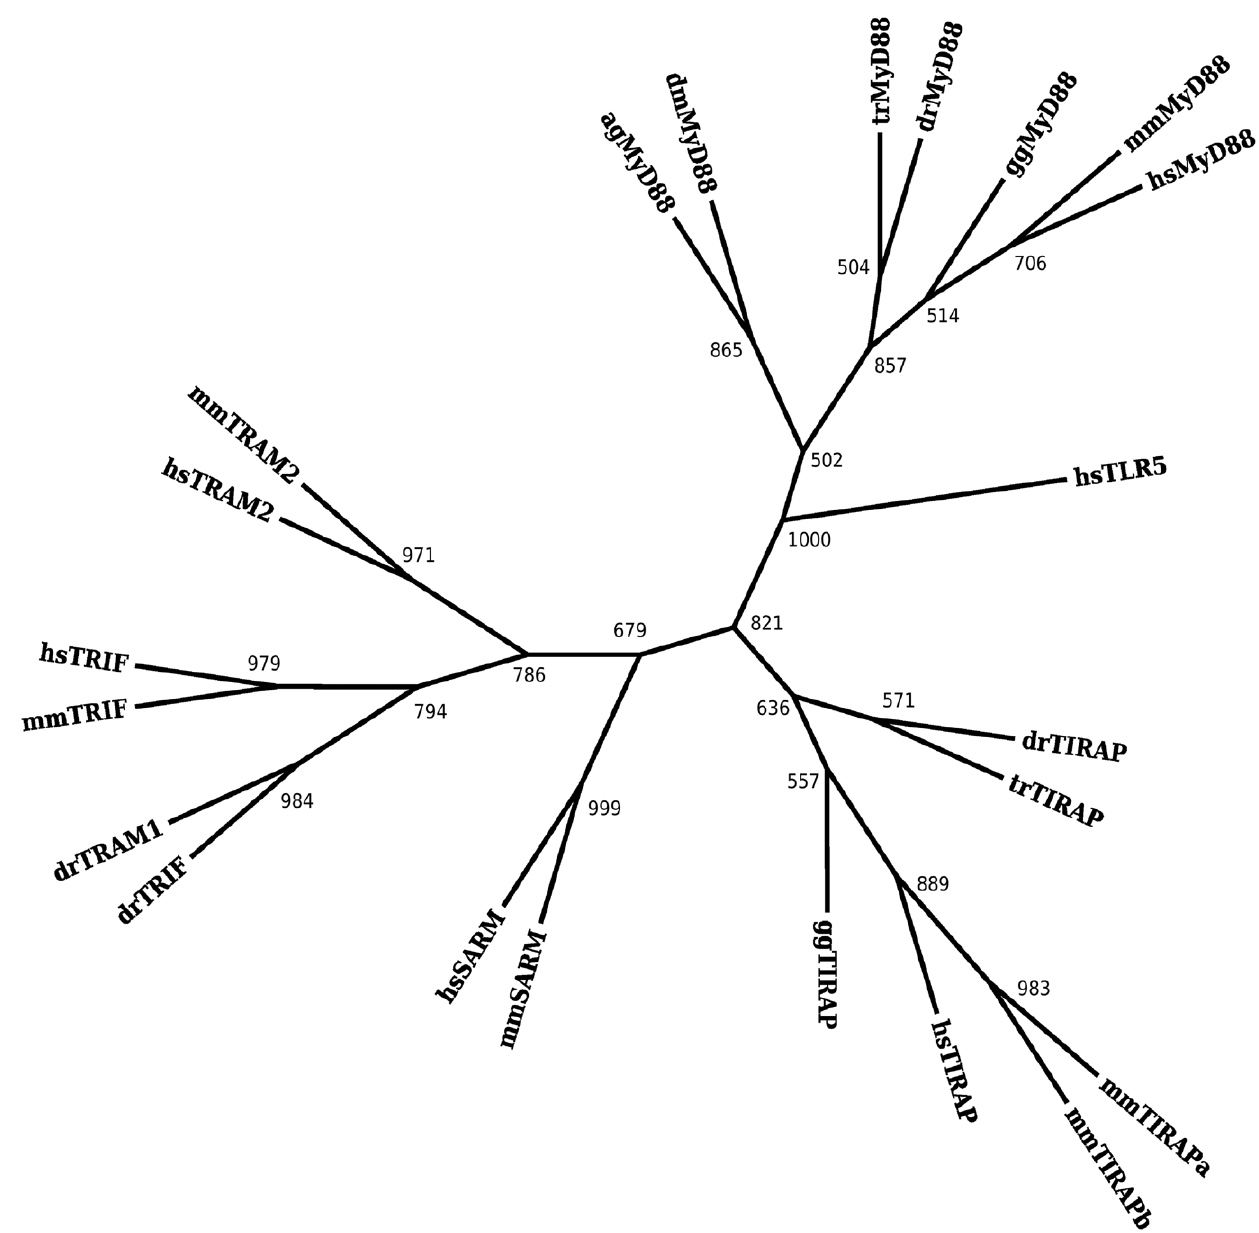
Figure 2. Maximum likelihood phylogeny of the TIR domain of the TLR adaptor molecules alone is consistent with the topology observed in Figure 1. The tree is rooted by the outgroup TIR domain of Homo sapiens TLR5. The numbers indicate boot-strap support out of 1000. Only values above 500 are indicated.